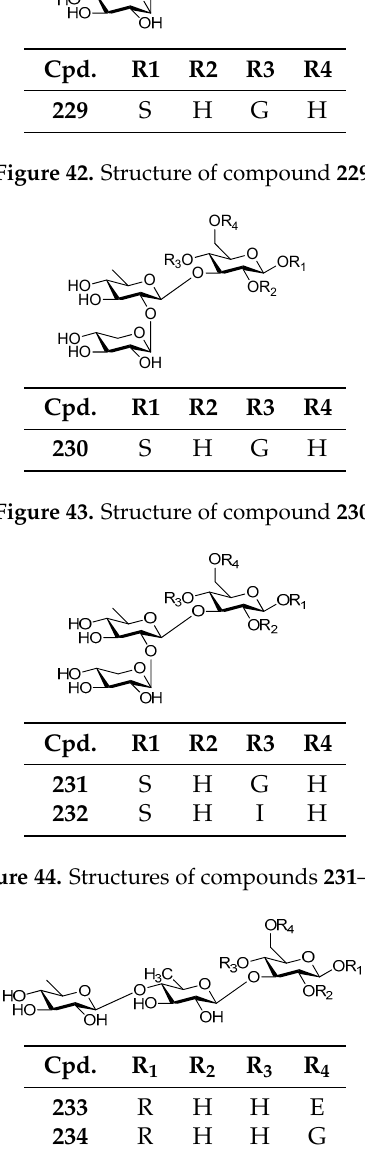
Figure 45. Structures of compounds 233 – 234.